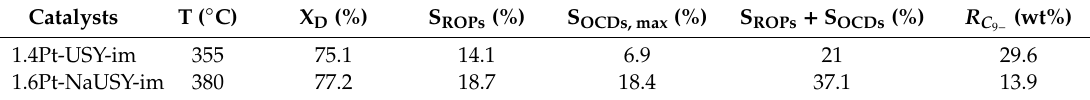
Table 5. Maximum selectivities of OCDs obtained for 1.4Pt-USY-im and 1.6Pt-NaUSY-im catalysts.